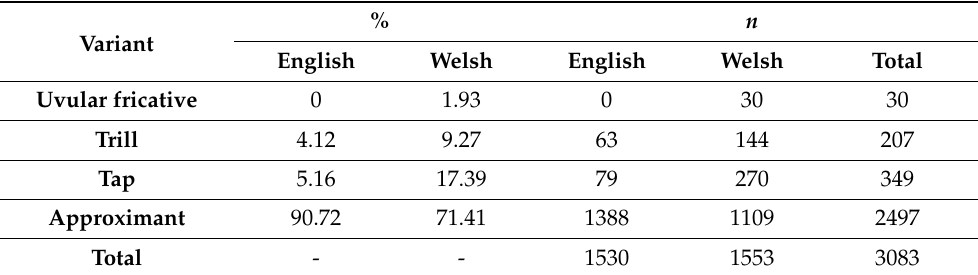
Table 5. Percentage and number of /r/ variants in the English and Welsh subsets ( n =